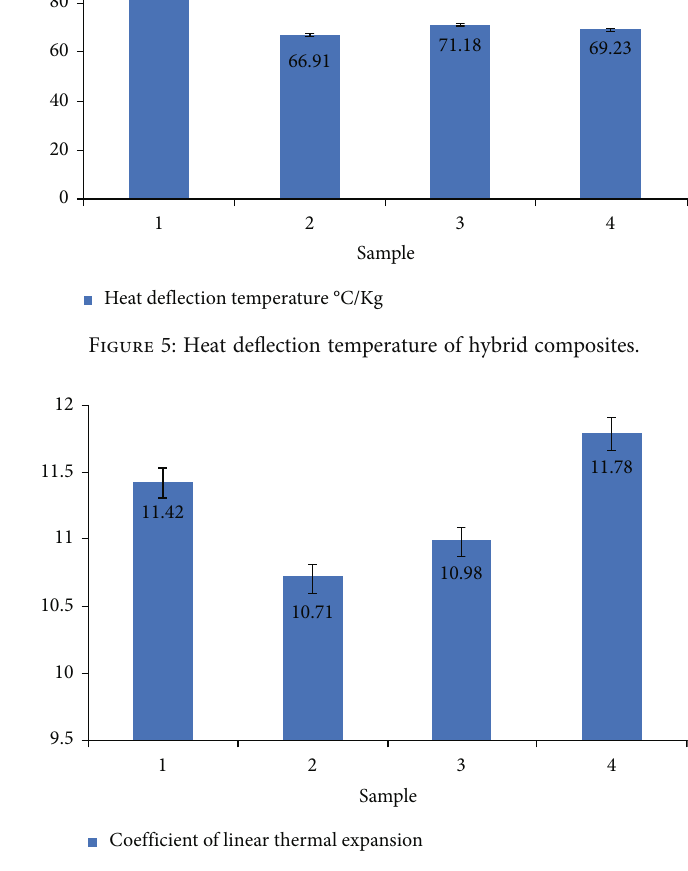
Figure 6: Coe ffi cient of linear thermal expansion of hybrid composites.